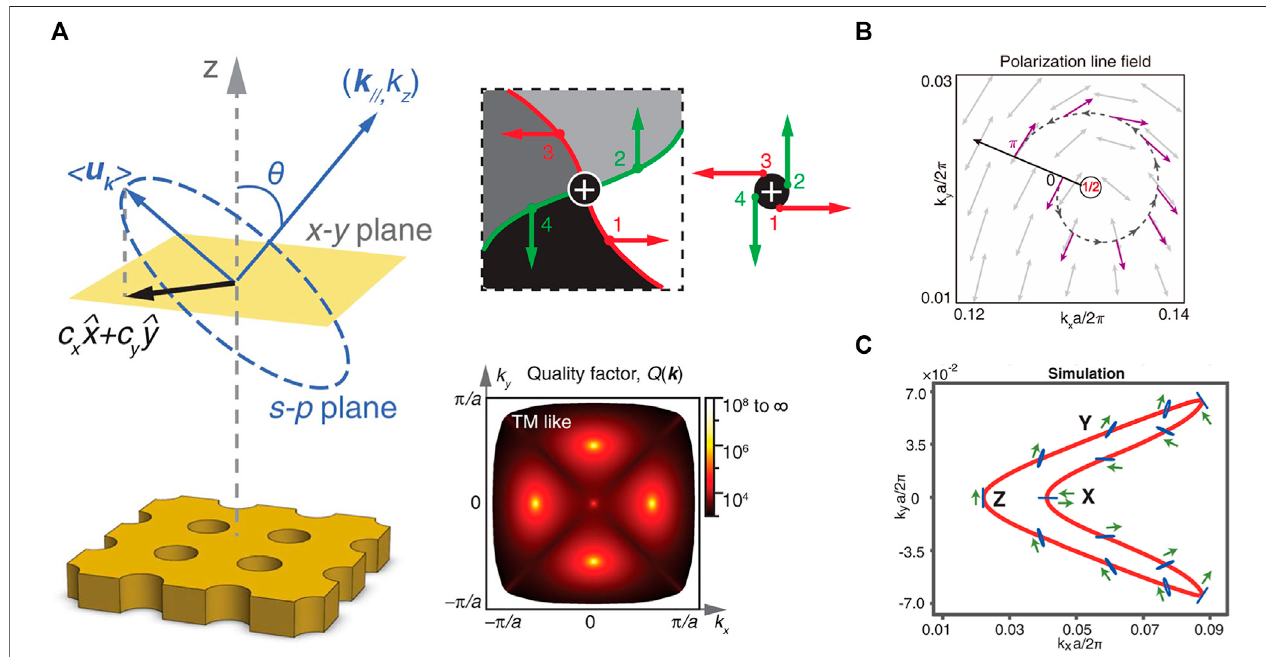
FIGURE 1 | De fi nitions and properties of different types of polarization singularities, (A) BICs [25] copyright American Physical Society; (B) a CP with charge +1/2 [43] copyright Springer Nature Ltd., and (C) a bulk Fermi arc connecting paried EPs [26] Copyright AAAS.